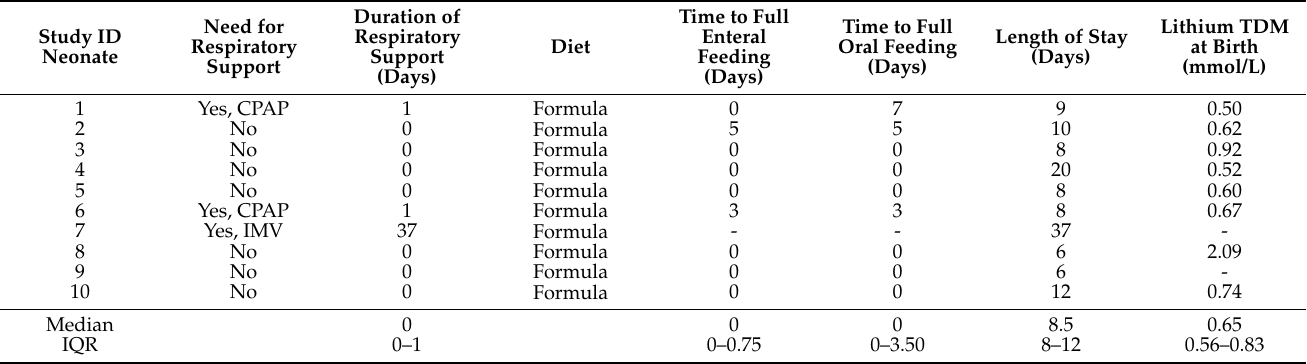
Table 3. Characteristics of the included neonates during their hospital stay.